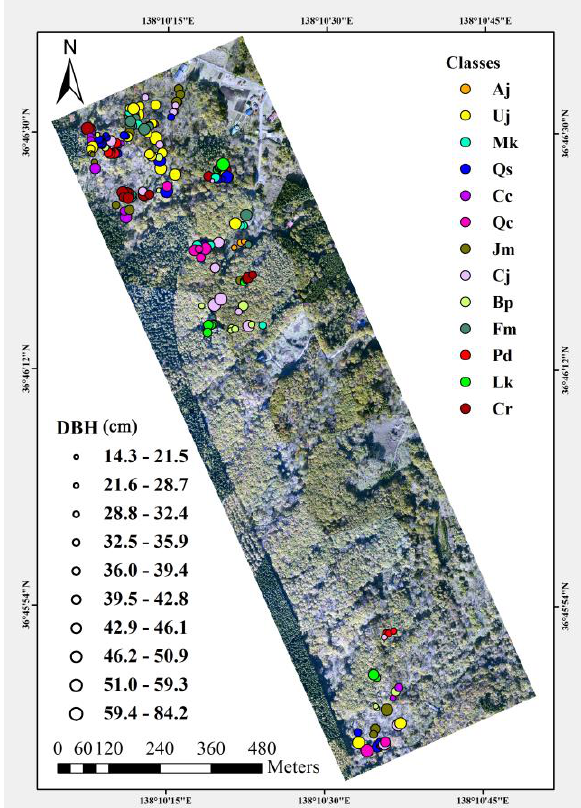
Figure 1. Field measurement results